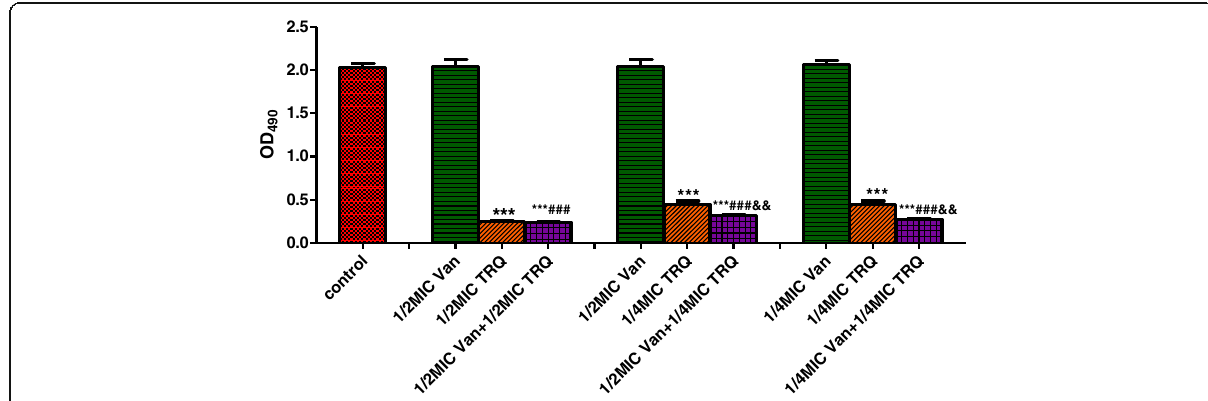
Fig. 3 Effect of TRQ combined with vancomycin on the preformed MRSA biofilm. Results are presented as the mean ± standard deviation of triplicate assays. (*** p < 0.001 vs. control group; ### p < 0.001 vs. vancomycin group; && p < 0. 01 vs. TRQ